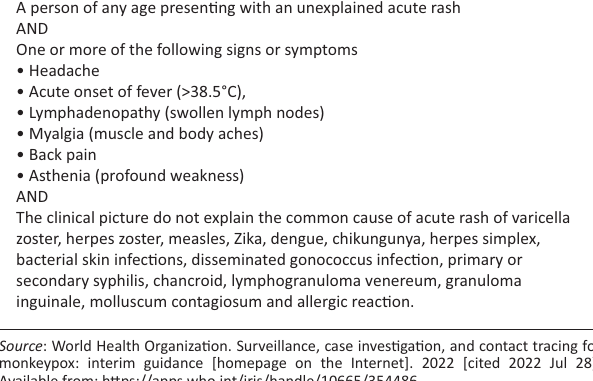
dengue. 6,11 Figure 1 and Figure 2 demonstrate monkeypox’s suspected and probable case definition.